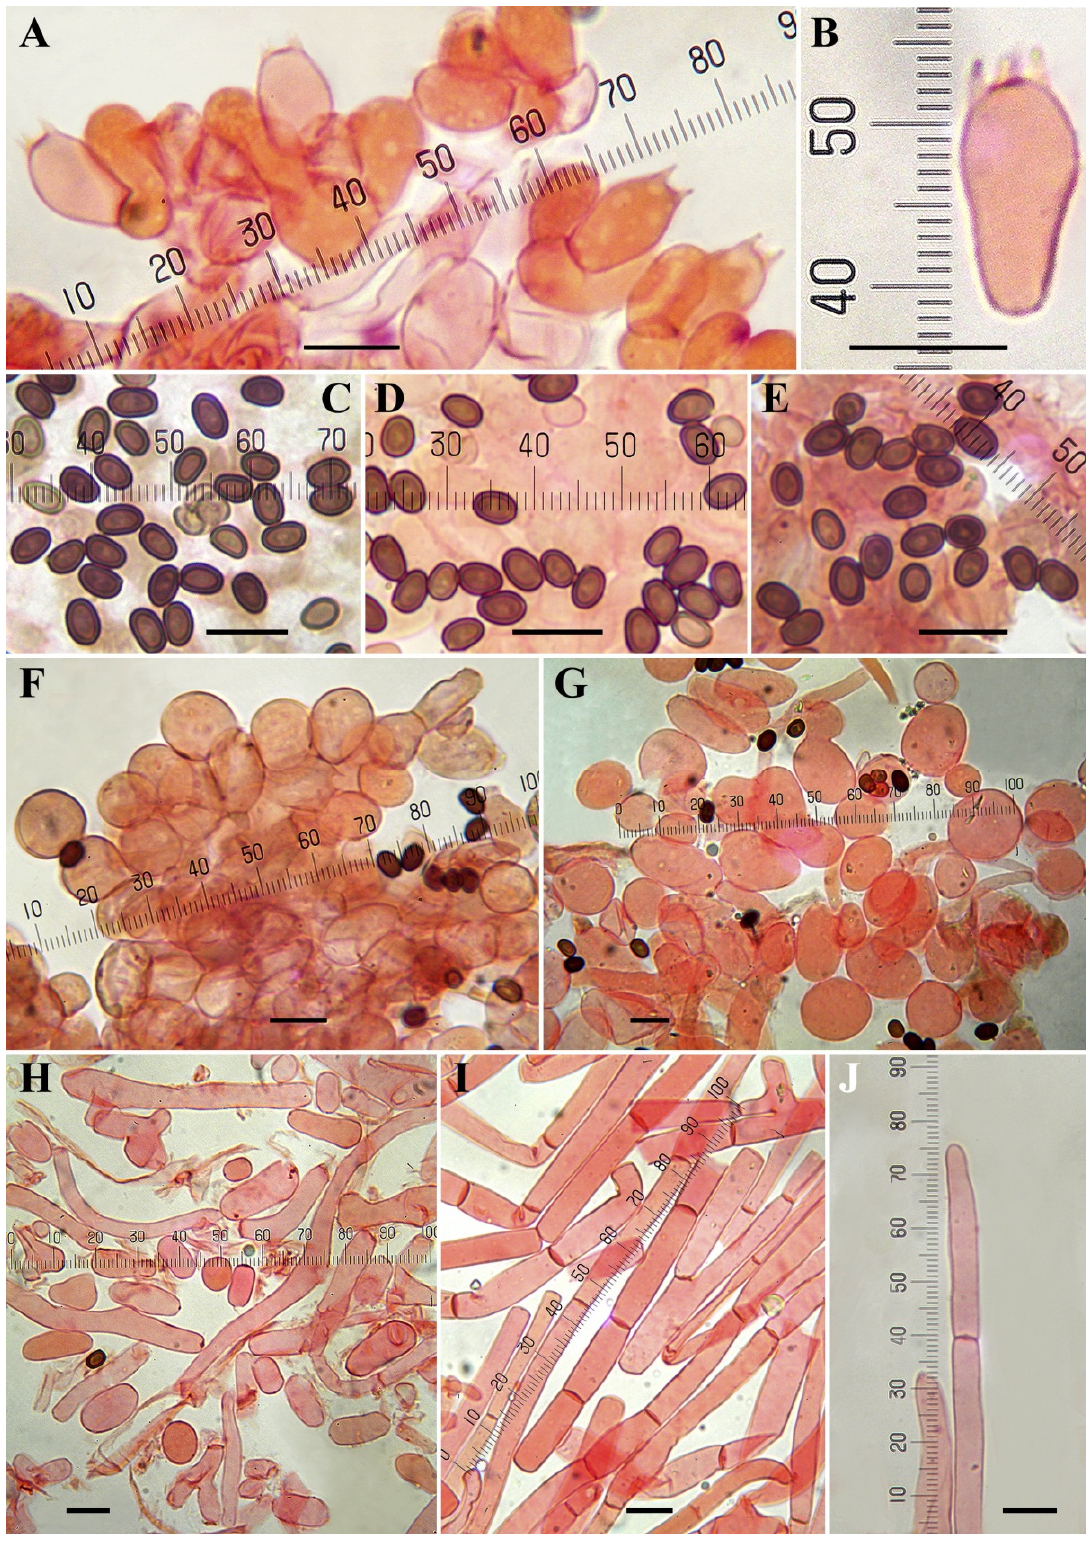
Figure 6. Microscopic characters of Agaricus macrochlamys from the Dominican Republic. ( A – J ) In ammonical Congo red. ( A , F ) JBSD126484; ( B , C ) JBSD126480; ( E , H – J ) JBSD126482; ( D , G ) JBSD130773; ( A , B ) Basidia; ( C – E ) Spores; ( F , G ) Cheilocystidia; ( H ) Hyphae of the lower surface of the annulus; ( I , J ) Pileipellis hyphae; ( J ) Terminal element. Bar = 10 μ m. Photos by L.A. Parra.